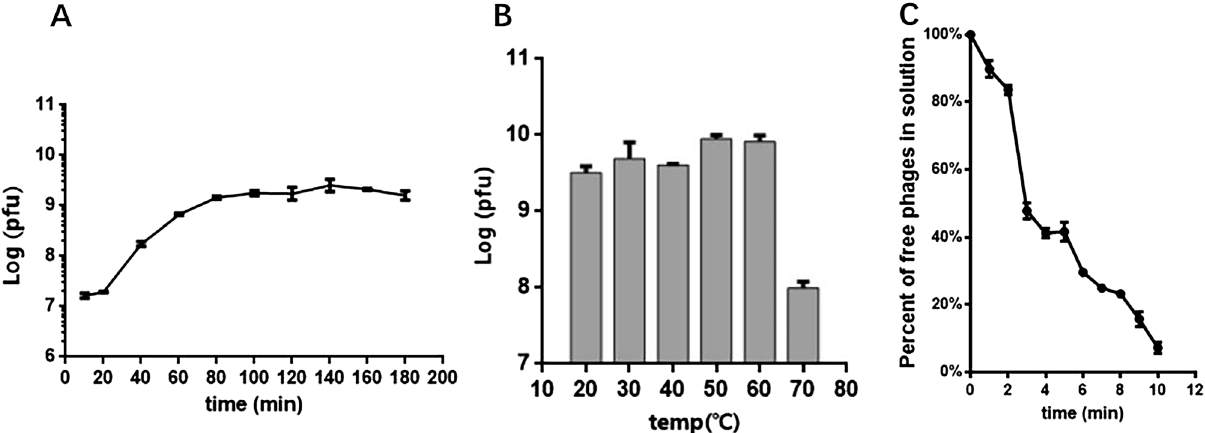
Figure 2. One-Step growth curve ( A ), thermal stability of Abp95 ( B ) and Phage Abp95 adsorption onto AB2013-95 ( C